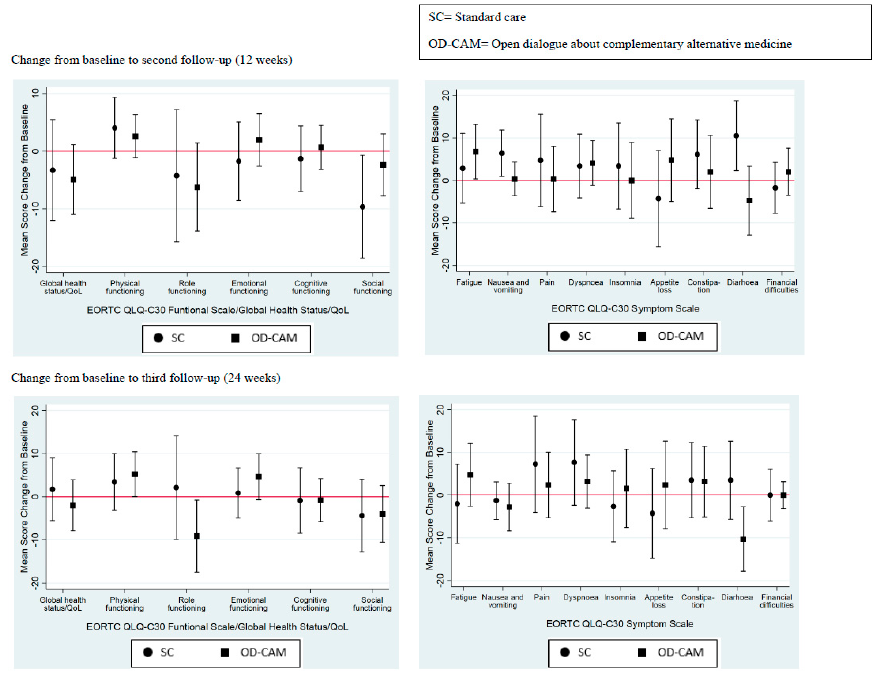
Figure 2. Quality of life.